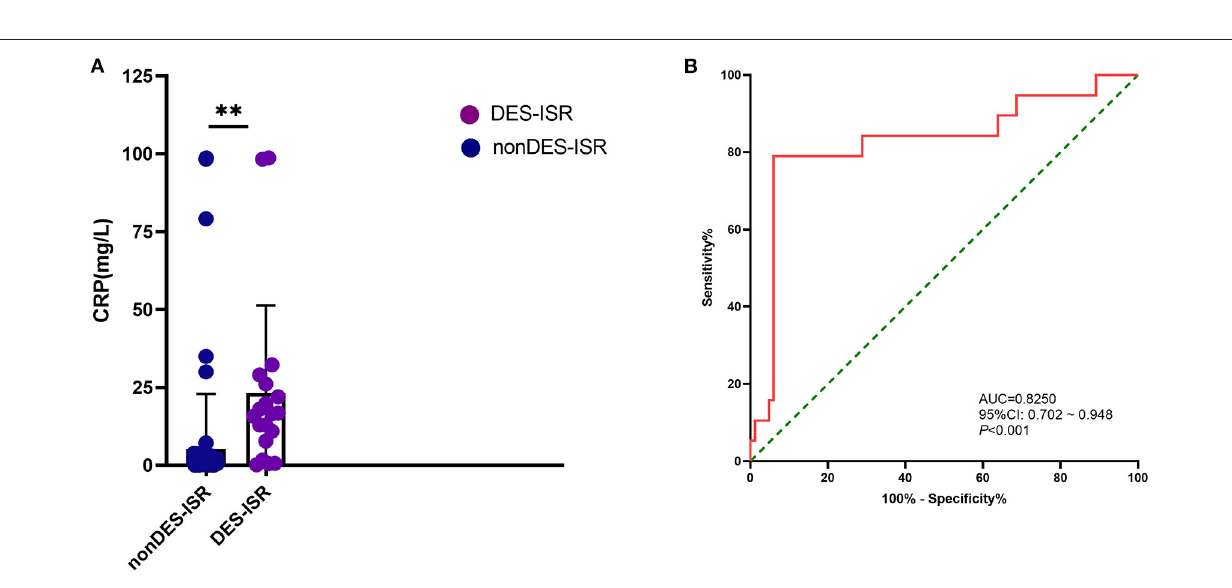
FIGURE 4 | Effects of CRP level on the DES-ISR. (A) The expression levels of CRP in the non DES-ISR and DES-ISR group. (B) ROC curve and its predictive performed of CRP level. ** P <